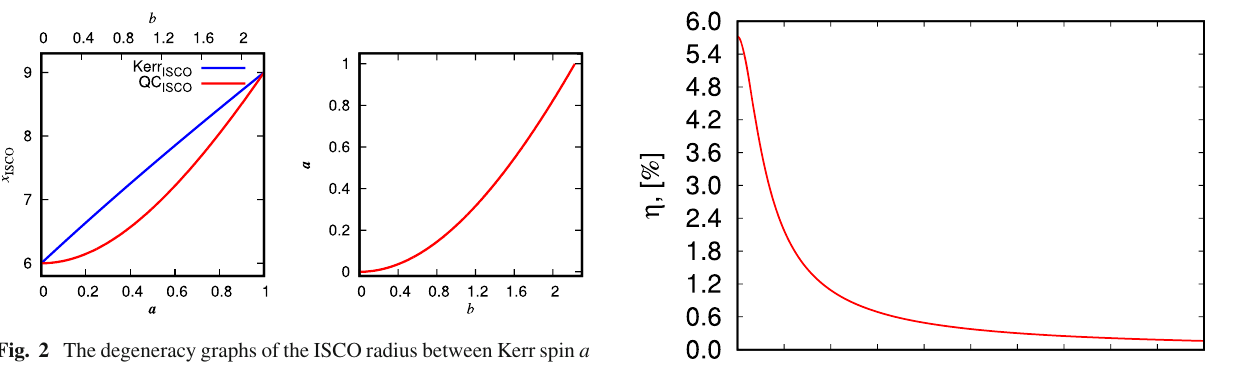
Fig. 2 The degeneracy graphs of the ISCO radius between Kerr spin a and the parameter b . Left: ISCO radius vs Kerr spin a and the parameter b . Right: Kerr spin a vs the parameter b with providing the same ISCO radius Ifquantum-correctedSchwarzschildblackholescouldmimic